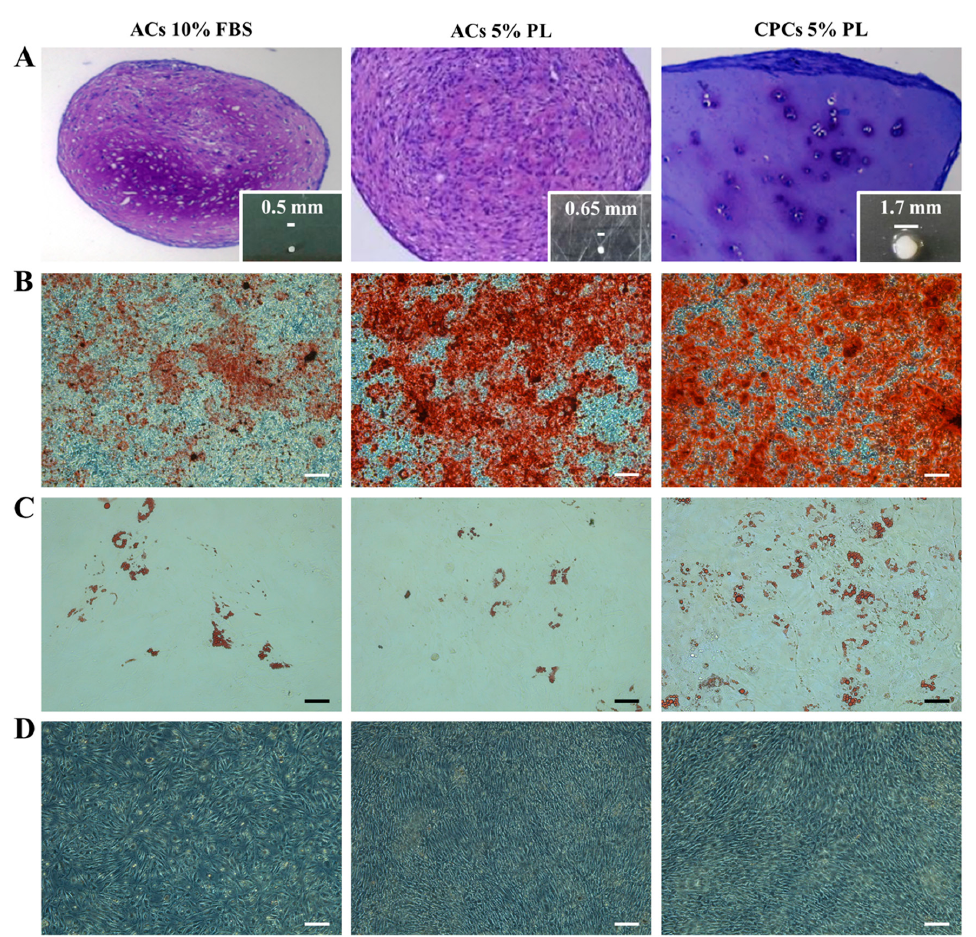
Figure 5. Multi-lineage di ff erentiation potential of ACs-FBS, ACs-PL and CPCs in vitro. ( A ) Toluidine blue staining of three-dimensional pellets formed by ACs 10% FBS, ACs 5% PL and CPCs 5% PL